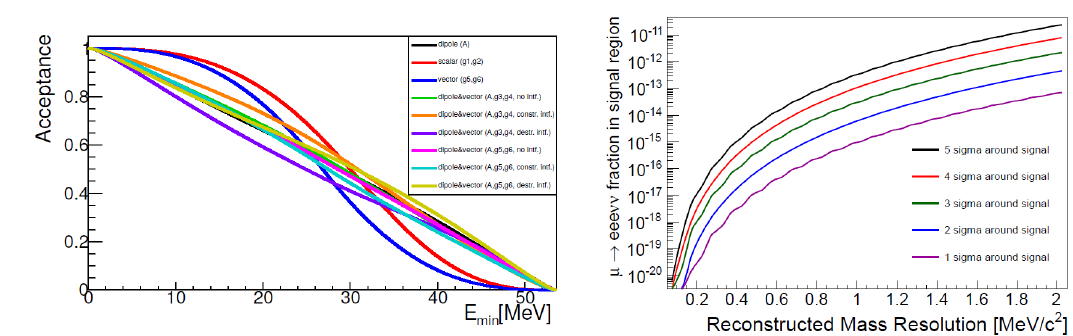
Figure 5: Coverage of the µ → eee decay as a function of the lowest detectable positron energy for different effective cLFV models. The black line corresponds to pure dipole and the red and blue lines to pure four-fermion contact interaction mod- els whereas the other lines correspond to a mixture of dipole and vector interactions (left). Contamination of the signal region (one sided cut) with internal conversion events ( µ → eee ν ¯ ν ) as a function of the visible three-particle mass resolution (right).